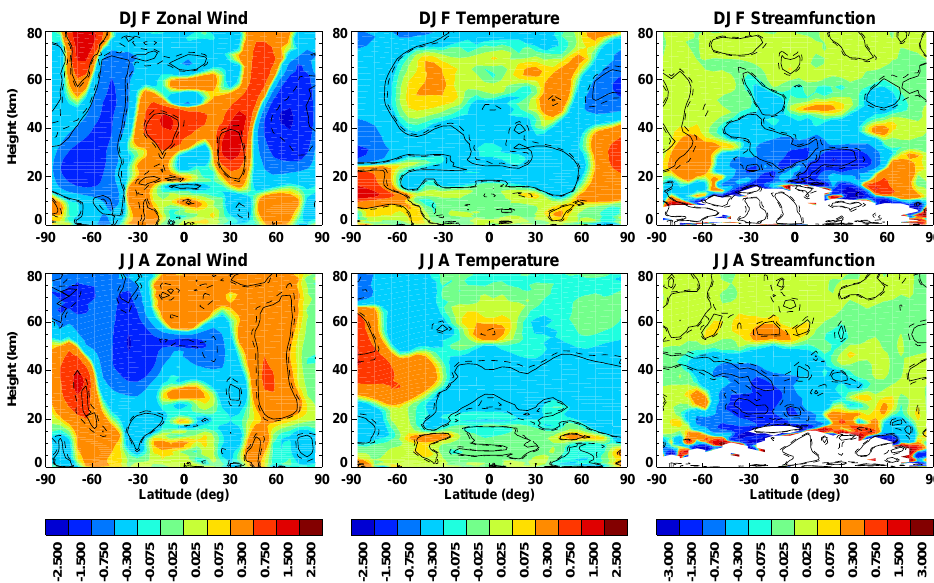
Fig. 14. December–February run mean, ensemble mean (top) and June–August run mean, ensemble mean (bottom) difference of the solar variability combined with EPP ensemble run from the solar variability only ensemble run for zonal wind (left, ms − 1 ), temperature (center, K), and mass streamfunction (right, kgm − 1 s − 1 , values outside the ( − 4,4) interval not plotted).